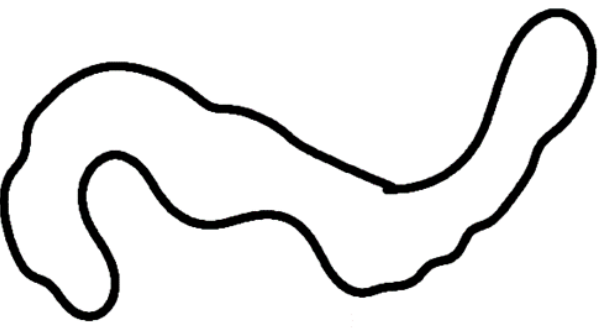
Figure 13. Schematic of evaluation 800-m circuit. Table 3. Vehicle